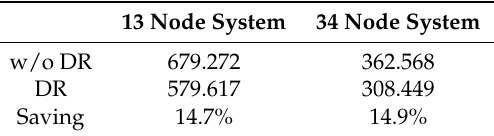
Table 1. Total cost of each